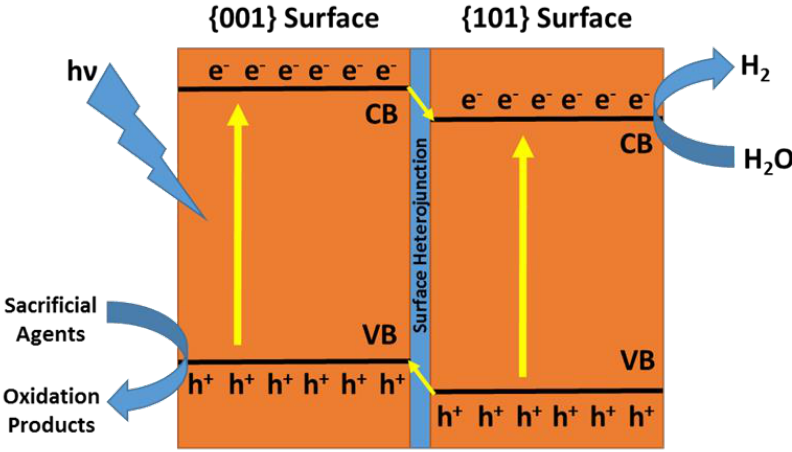
Figure 8. Energy-level diagram and charge carriers transfer process of the “surface hetero-junction” between facets {101} and {001} of TiO 2 anatase under UV irradiation.